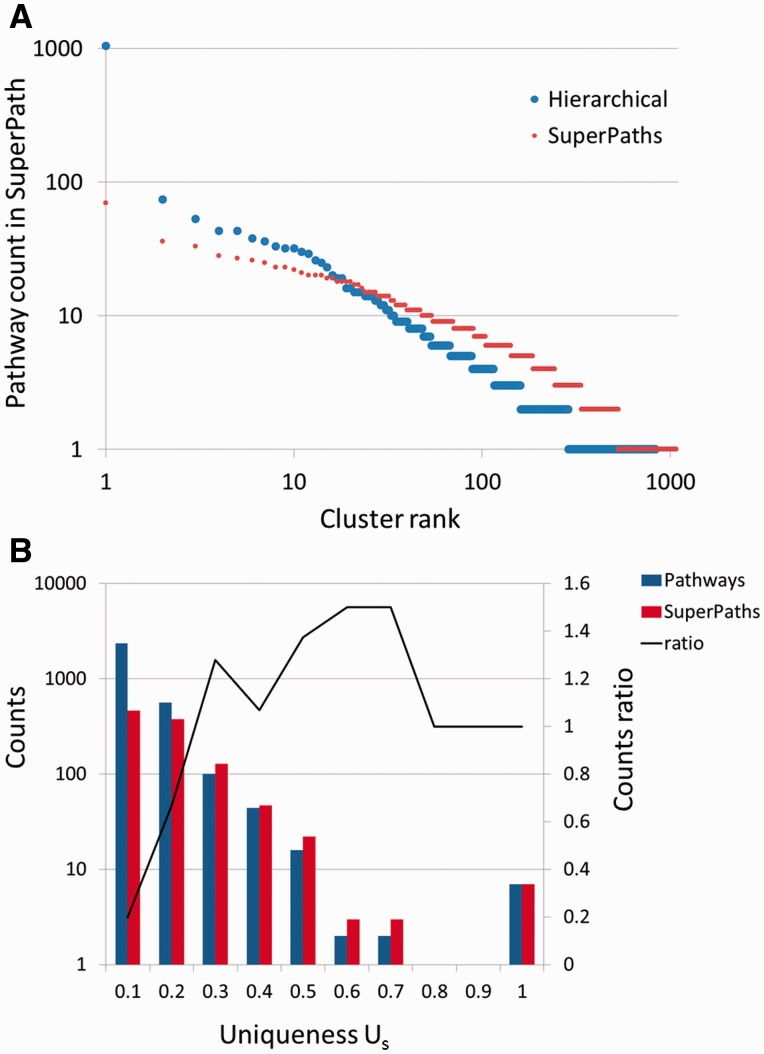
SuperPaths increase uniqueness while keeping high informativeness. (A) Number of pathways in hierarchical clustering versus SuperPath algorithm. The largest cluster with hierarchical clustering includes 1046 pathways, about 33% of the entire input, causing a great reduction of informativeness. In the SuperPath clustering the maximum cluster size is 70, about 2% of all pathways. (B) Increase in uniqueness (Us) following unification of pathways into SuperPaths.